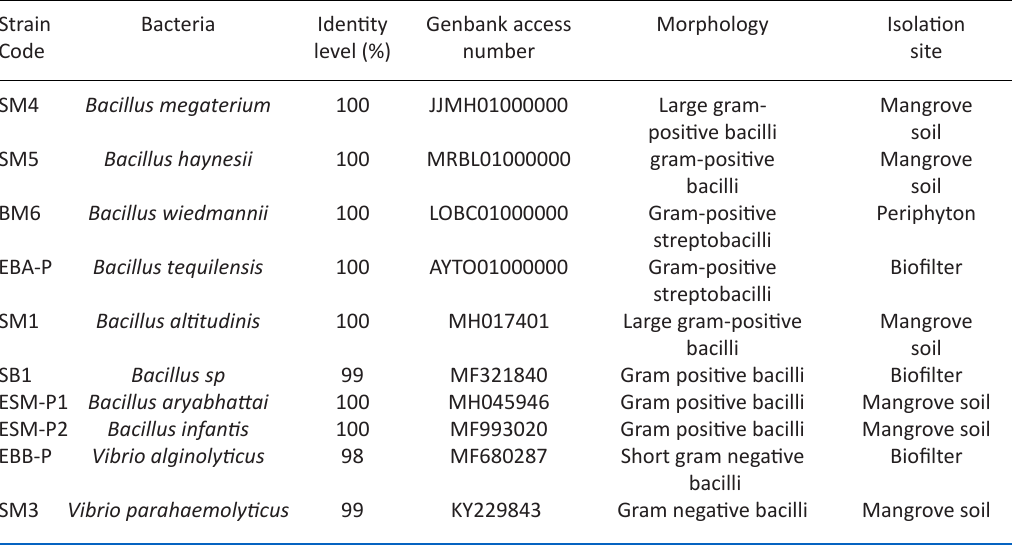
Table 2. Molecular identification of native bacterial strains isolated from biofilter, periphyton and mangrove soil by sequence